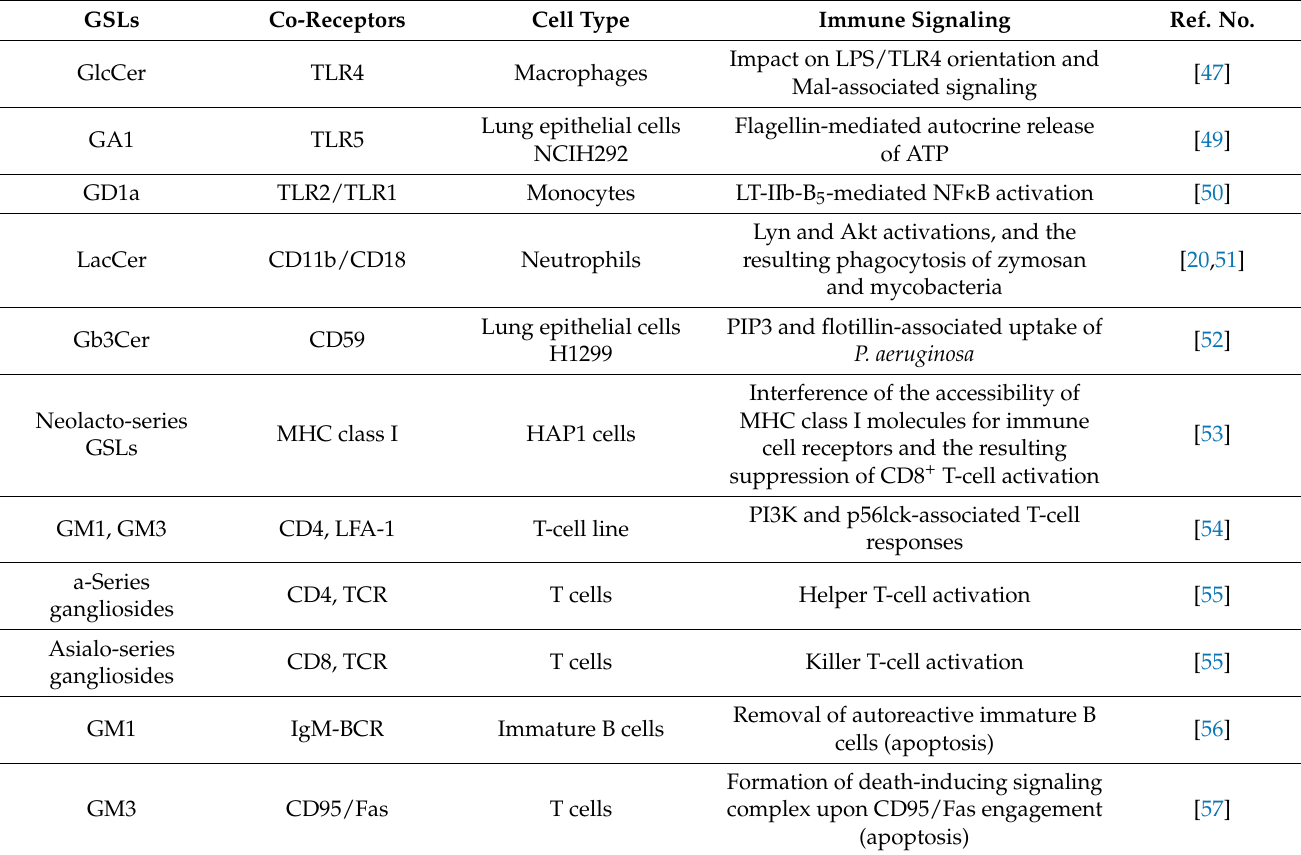
Table 1. GSLs and receptor-mediated immune